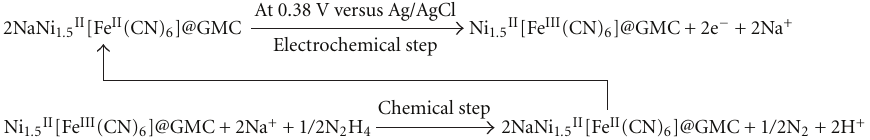
Scheme 2: Reaction mechanism for the electrocatalytic oxidation of hydrazine on GCE/NiHCFe@GMC utilizing its A1/C1 redox couple.